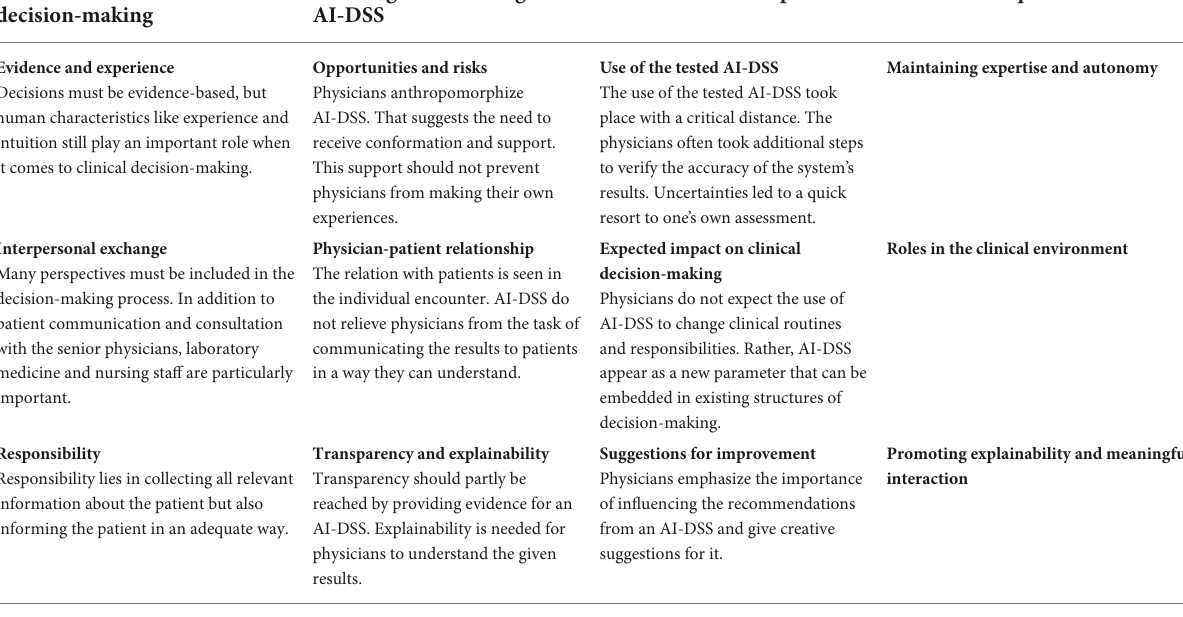
TABLE 1 Themes in the results and inferred normative